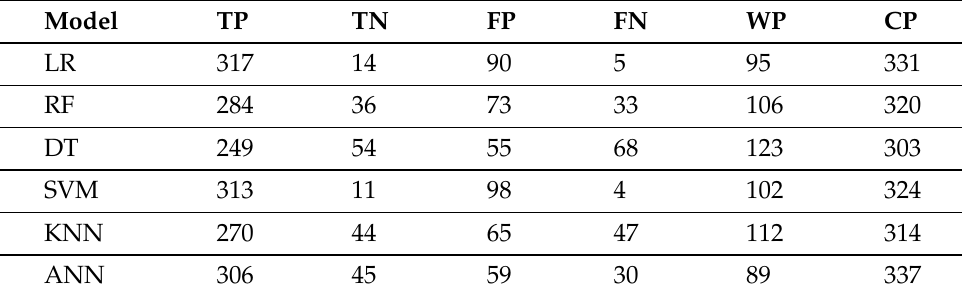
Table 8. Confusion matrix of classification algorithms used in this study.